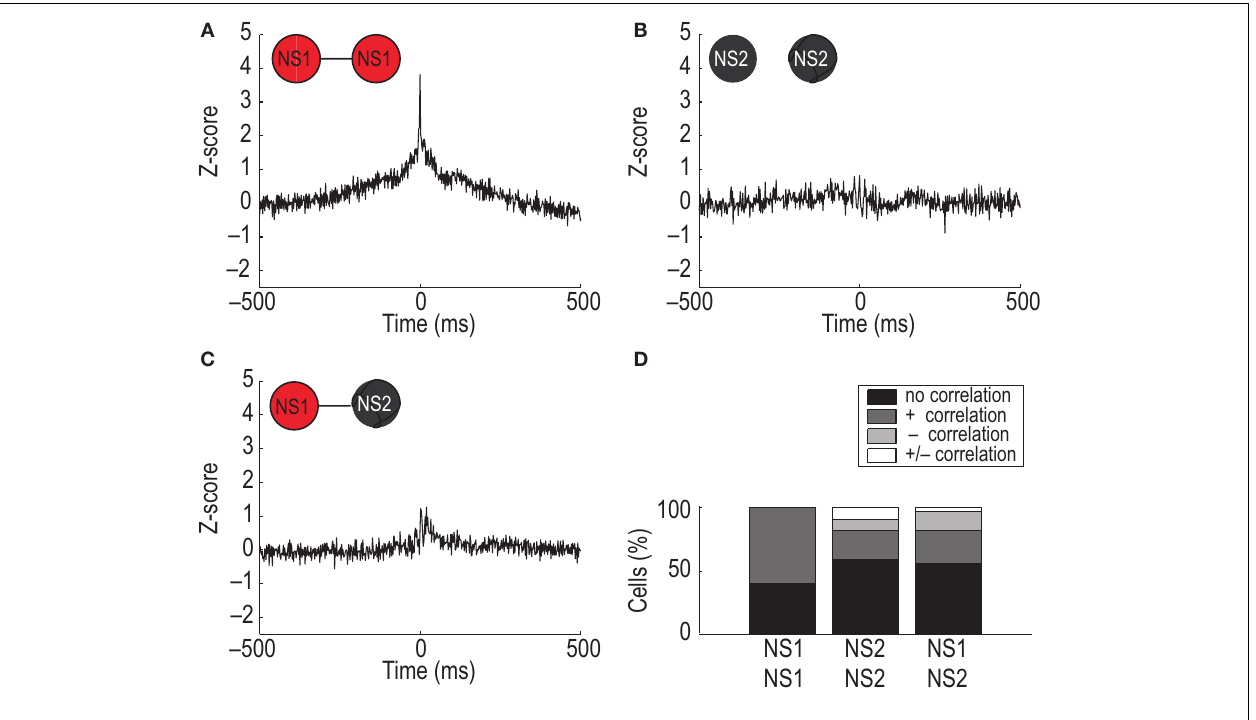
FIGURE 5 | Cell-type specifi c interneuronal network interactions. (A) Average CCH for pairs of simultaneously recorded NS1 neurons showing a signifi cant increase in correlated fi ring [ x -axis: time lag of correlation (ms); y -axis: correlation value relative to baseline]. (B,C) Flat CCHs for populations NS2–NS2